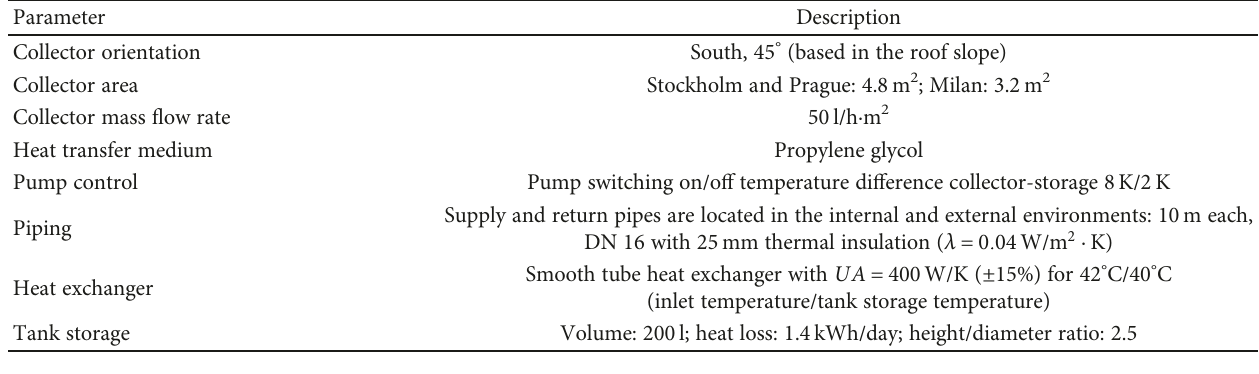
Table 4: Solar domestic hot water system parameters and operating conditions for given alternatives (RS, V1, V2, and V3).